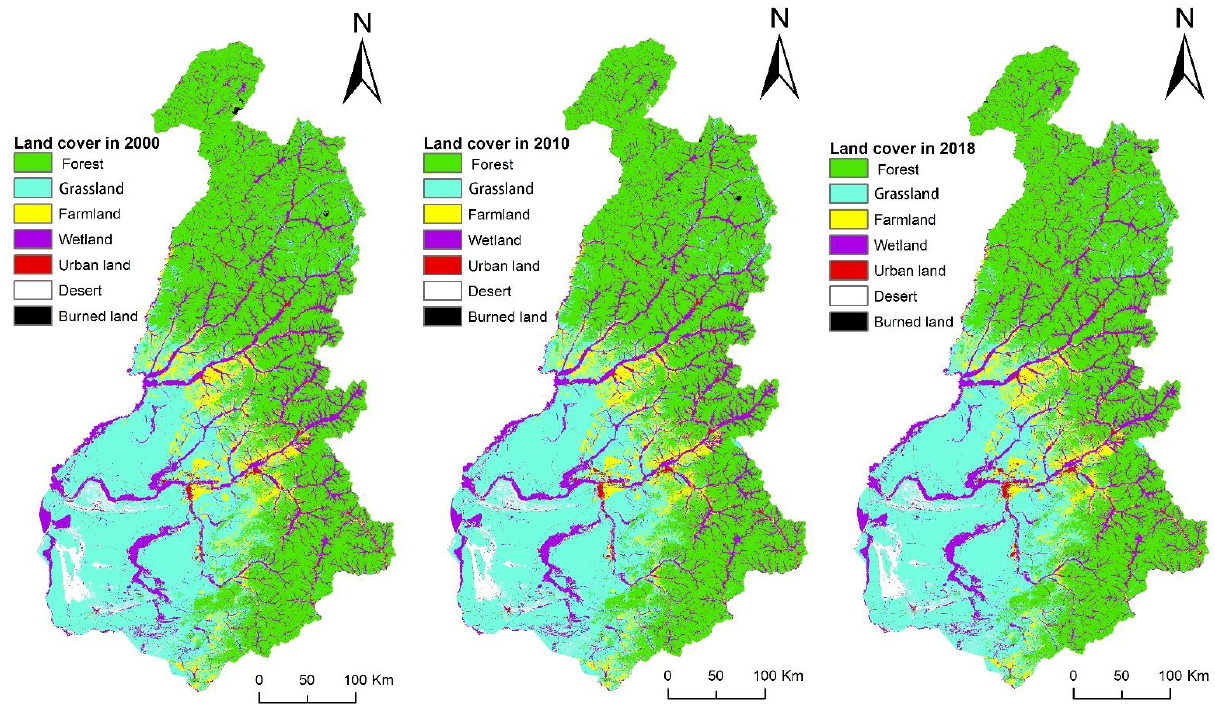
Figure 6. Land cover change in the forest-steppe ecotone of the Greater Khingan Mountains from 2000 to 2018.